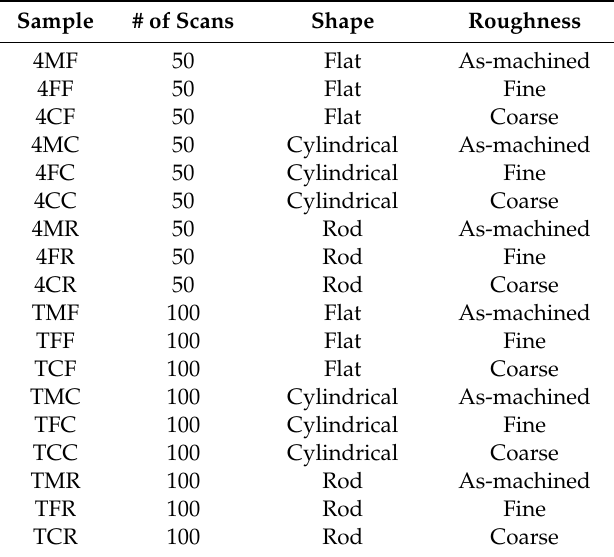
Table 3. Design of experiments of samples